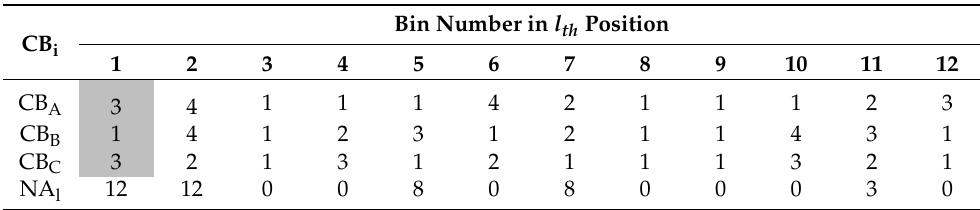
Table 7. Combination of bins.